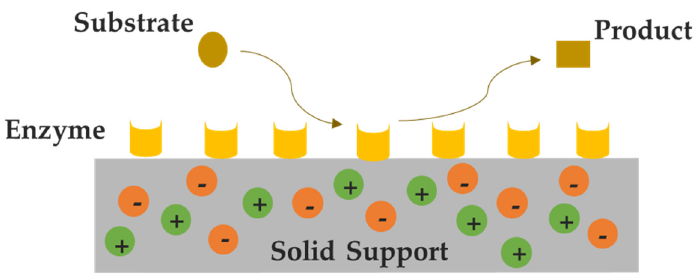
Figure 3. Schematic representation of a biocatalytic system based on SIL. IL is confined in the solid support (gray), whereas the enzyme (yellow) is immobilized over the modified support.